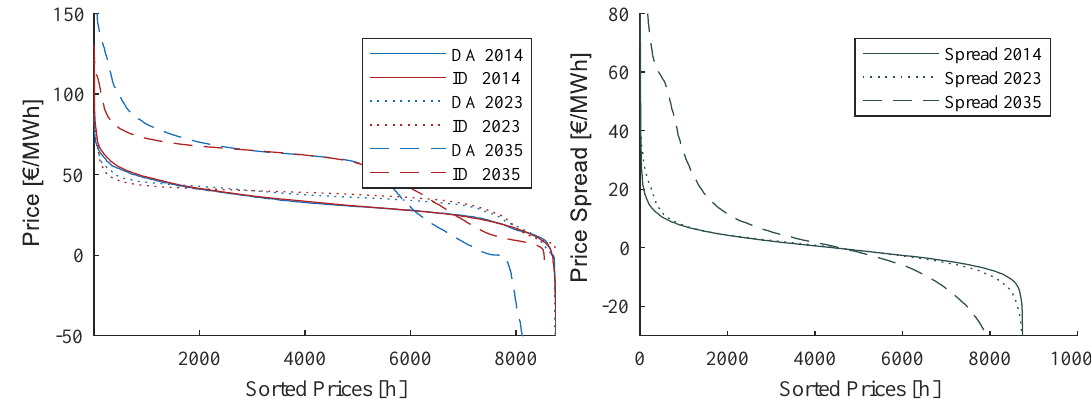
Figure 13. Price duration curve of the DA and ID market in Germany ( left ) and its price spread ( right